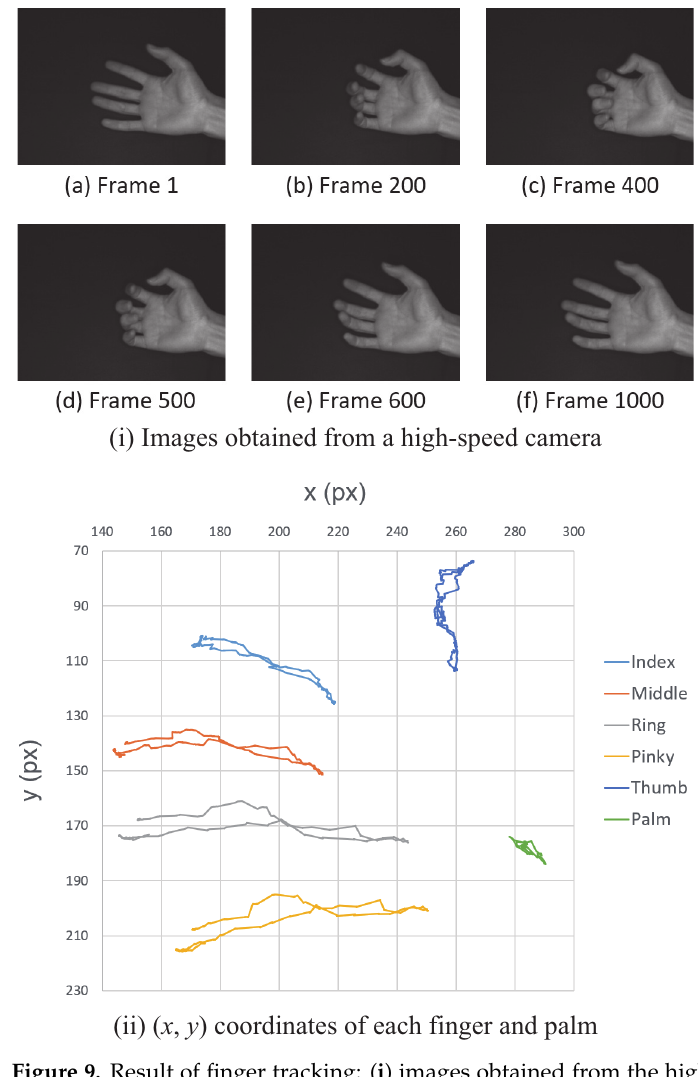
Figure 9. Result of finger tracking: ( i ) images obtained from the high-speed camera and ( ii ) ( x , y ) coordinates of each finger and the